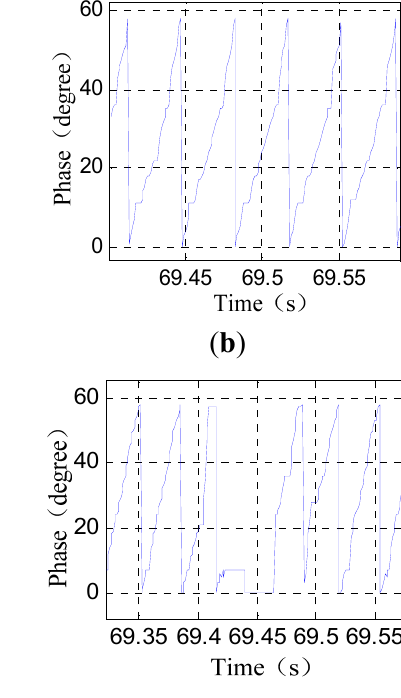
Figure 7. Phase data under different working conditions: ( a ) normal; ( b ) when the suspension gap is too large; ( c ) near a 86 mm joint gap; ( d ) near a 172 mm joint gap.